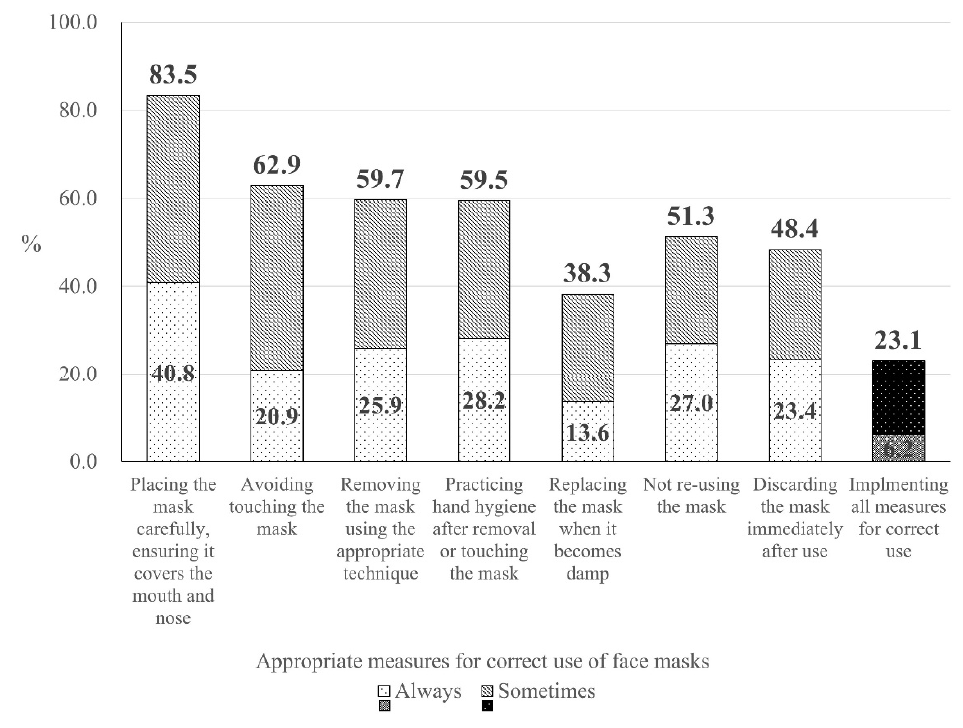
Figure 1. The prevalence of correct use of face masks. When a participant responded with 1 or 2 (“Always careful” or “Sometimes careful”) on the 4-point-Likert scale, it was determined that the respondent was using face masks correctly.